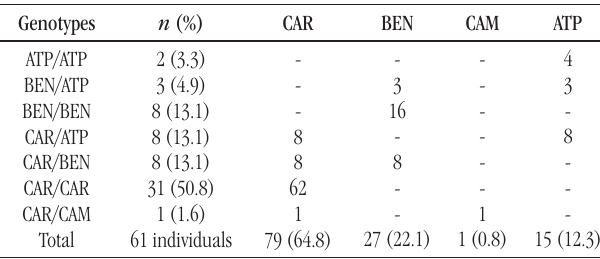
taBLE 2 − Distribution of genotypes and haplotypes